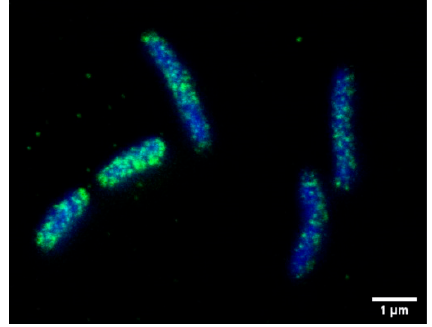
Figure 3. Localization of CagA in H. pylori . CagA (green) was detected using an anti-CagA antibody and analyzed by STED microscopy. Bacterial DNA was stained using DAPI (blue). Bar, 1 µM.